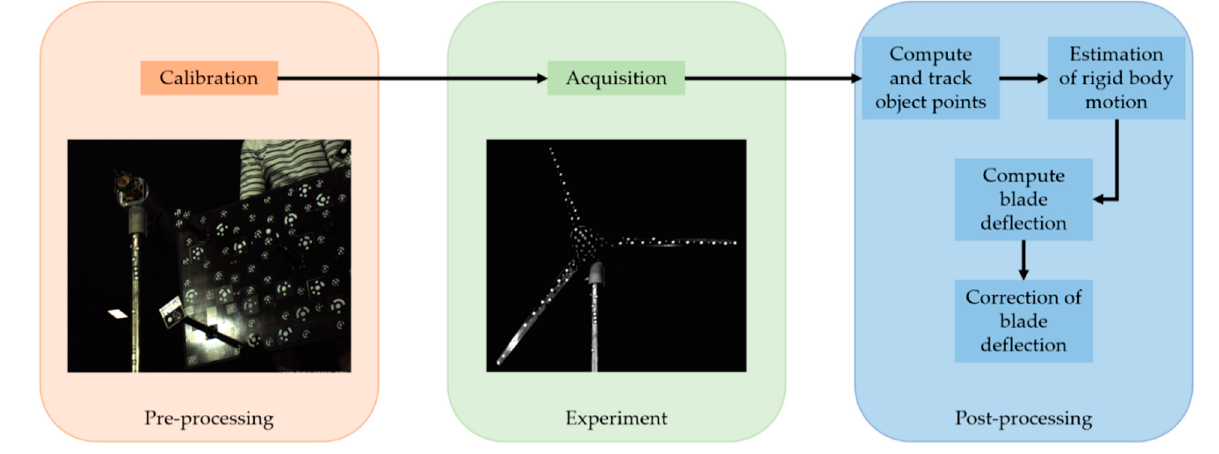
Figure 4. Processing chain of photogrammetry.